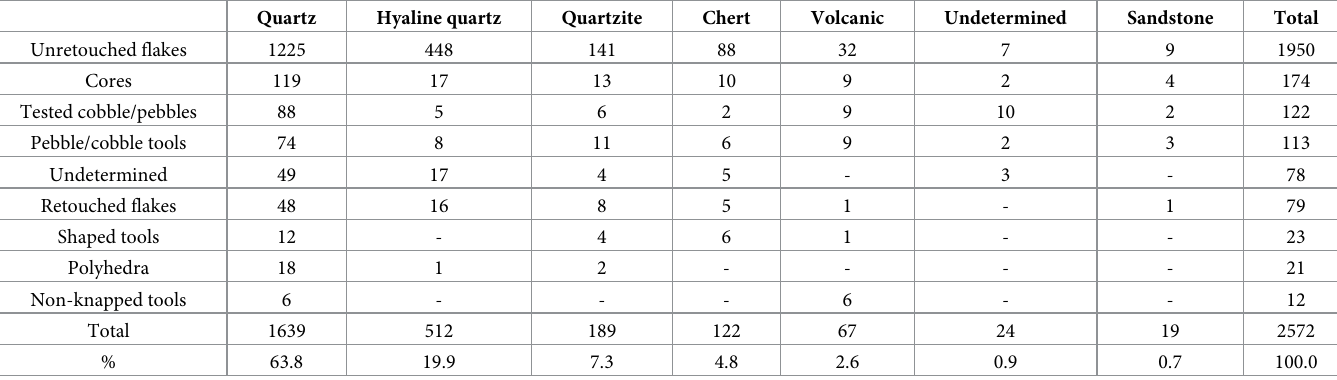
Table 4. Raw material distribution per techno-typological category of Dungo IV. Quartz Hyaline quartz Quartzite Chert Volcanic Undetermined Sandstone